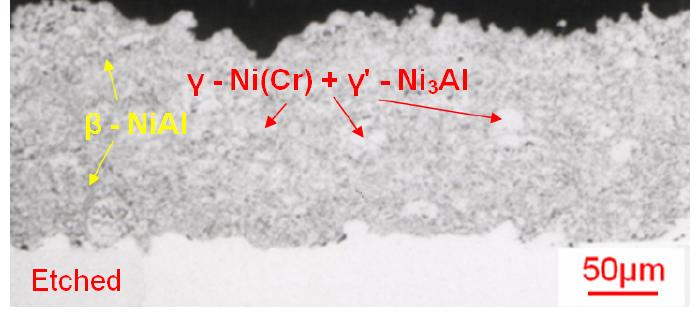
Figure 3 – (OM) Etched microstructure of the vacuum plasma sprayed Ni22Cr10Al1Y coating Рис . 3 – ( ОМ ) Поврежденная микроструктура покрытия , нанесенного вакуумным превлаке